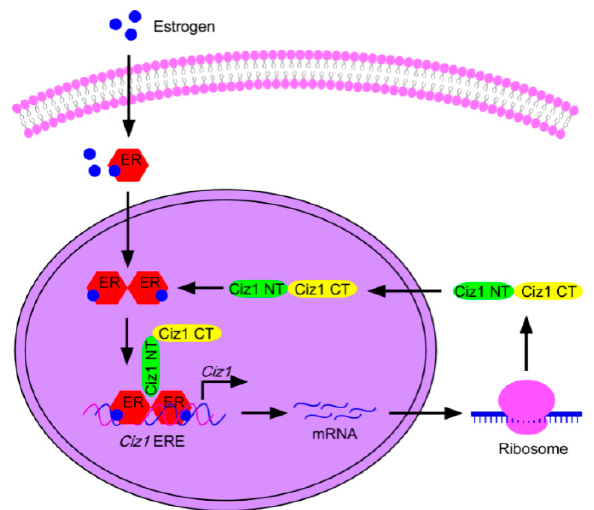
Figure 4. Interactions of CIZ1 and estrogen receptor signaling. Estrogen is captured by estrogen receptor- α in the cytoplasm, then the activated estrogen receptor- α is dimerized and translocates into the nucleus. CIZ1 interacts with estrogen receptor- α through the N-terminal and promotes the binding of estrogen receptor- α and the responding element, activating the transcription of targeted genes, including CIZ1 . Estrogen-induced CIZ1 reciprocally enhances the activity of the estrogen-estrogen receptor- α signaling pathway, forming a positive feedback loop [6]. ER: estrogen receptor.